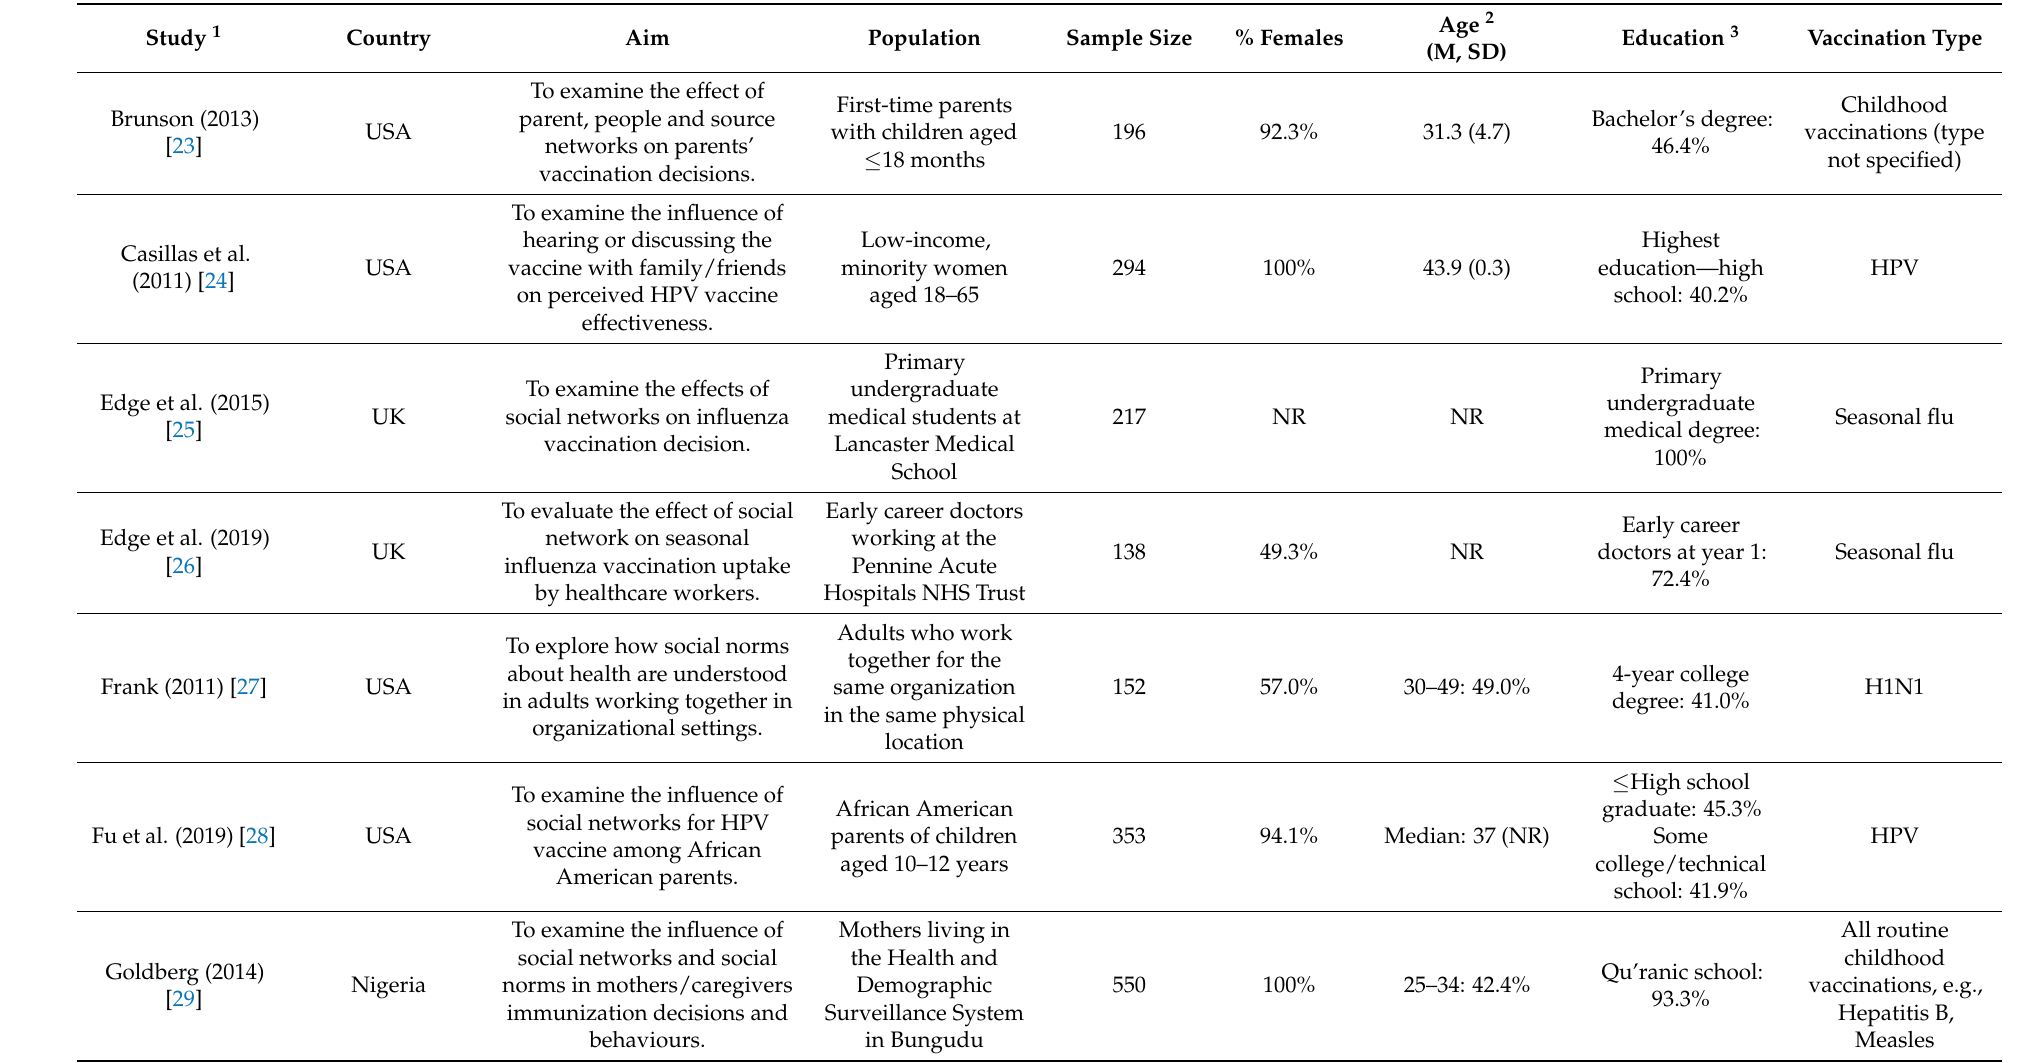
Table 1. Descriptive information of included studies ( n =